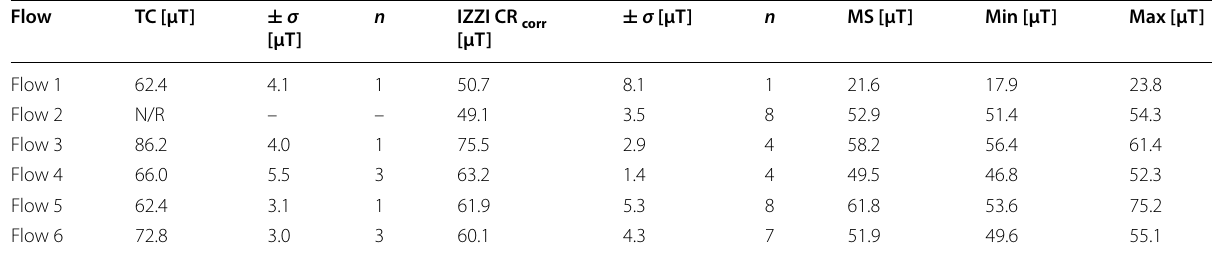
Table 5 Summary of the mean PI values from three methods for the six flows